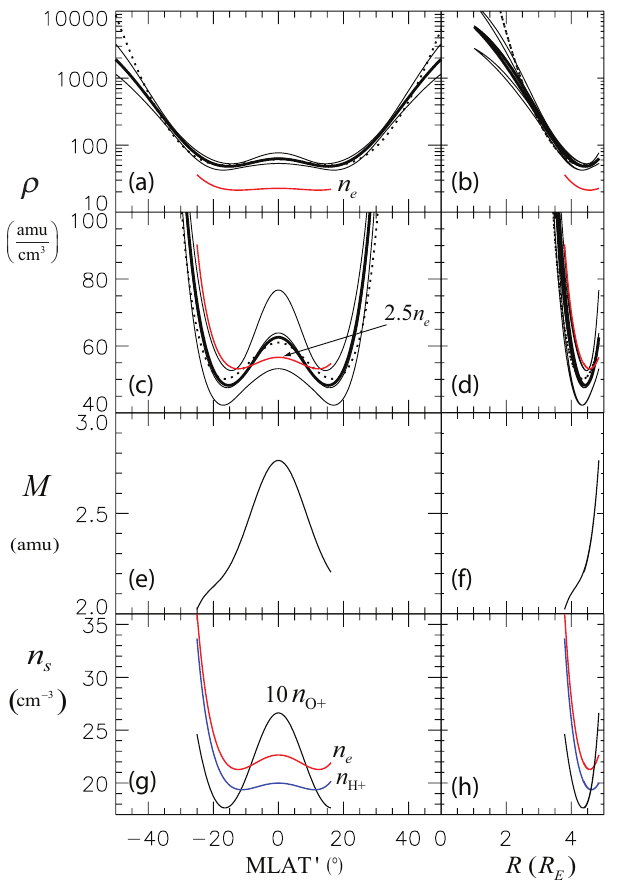
Fig. 7. (a, b) Mass density ρ (black curves) and electron density n e (red curves) versus MLAT 0 (left) and R (right). The black solid curves are all found using a three term polynomial expansion for ρ with respect to τ . The thick black solid curve is the solution based on the peak frequencies in Table 3, the middle thin black solid curve (obscured in (a, b) by the thick black solid curve) is the mean solution from the Monte Carlo simulation using the uncertainties listed in Table 3, and the upper and lower thin black solid curves are the mean solution plus or minus one standard deviation (in the log value). The black dotted curves are found using a three polynomial expansion with respect to z . The red curve is n e found from fit 5 as described in the text. (c, d) The same quantities are plotted with a smaller linear scale. Here, the values of n e (red curve) are multiplied by a factor 2.5. (e, f) Average ion mass M ≡ ρ/n e based on the thick solid black and red curves in (a–d). (g, h) Species densities (of species s) based on M assuming a three species plasma with H+, O+, and electrons. The values of n O + are multiplied by a factor of 10.